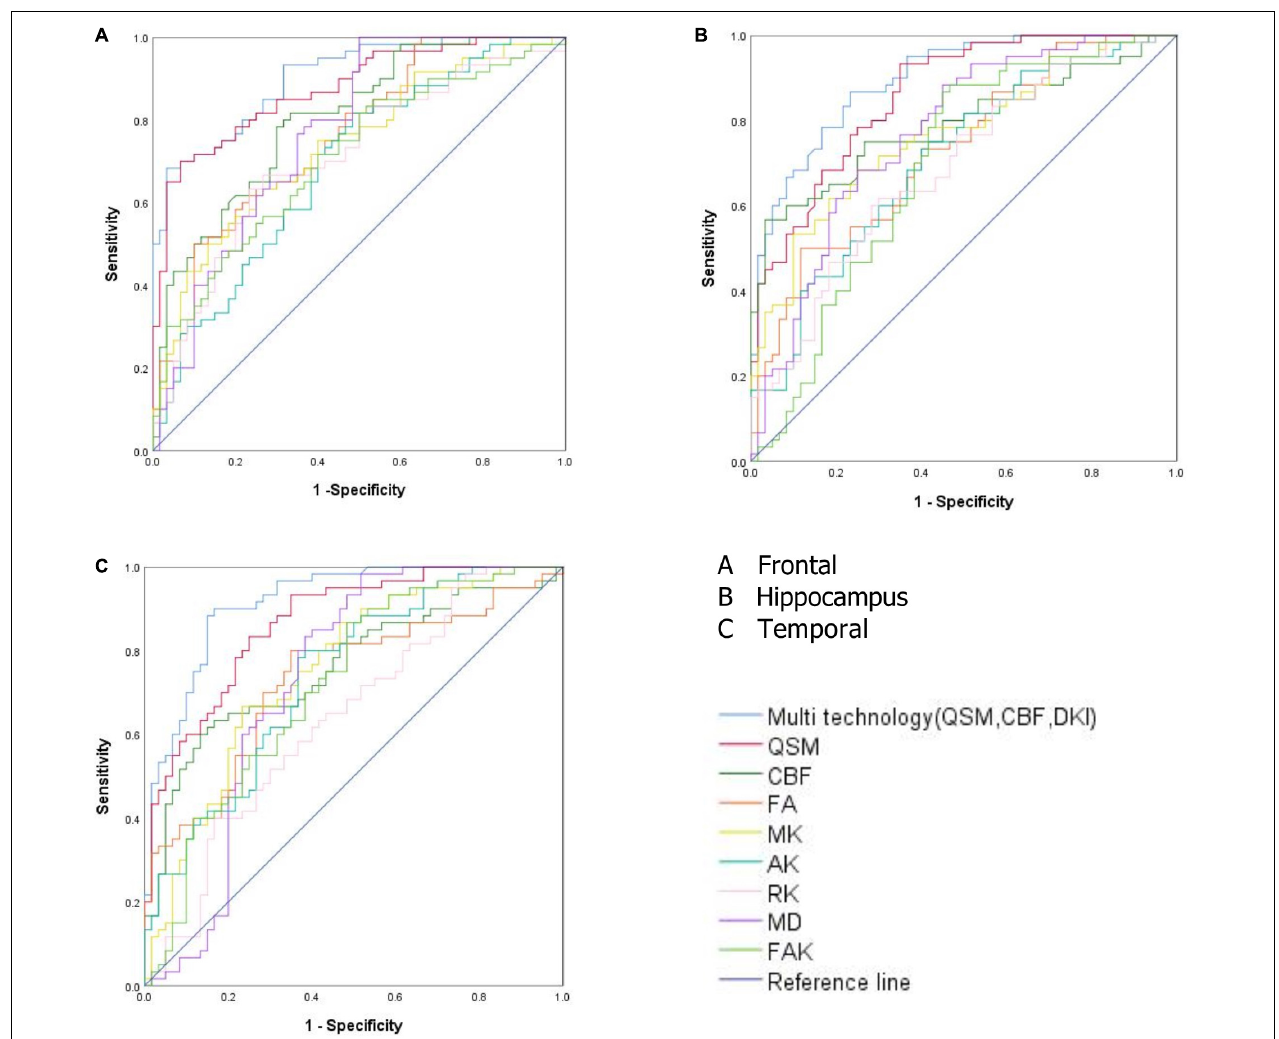
FIGURE 4 | (A) Receiver operating characteristic (ROC) curve analysis results of quantitative susceptibility mapping (QSM), cerebral blood flow (CBF), diffusion kurtosis imaging (DKI), and multimodal technology (QSM, CBF, DKI) values in frontal lobe. (B) ROC curve analysis results of QSM, CBF, DKI, and multimodal technology (QSM, CBF, DKI) values in hippocampus. (C) ROC curve analysis results of QSM, CBF, DKI, and multimodal technology (QSM, CBF, DKI) values in temporal